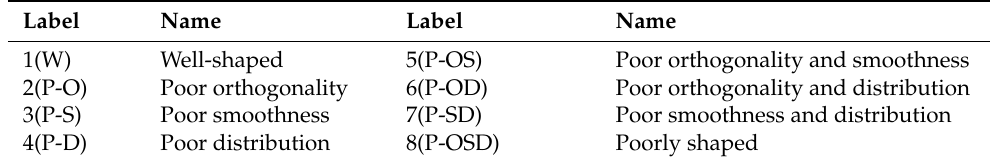
Table 2. Different types of meshes.